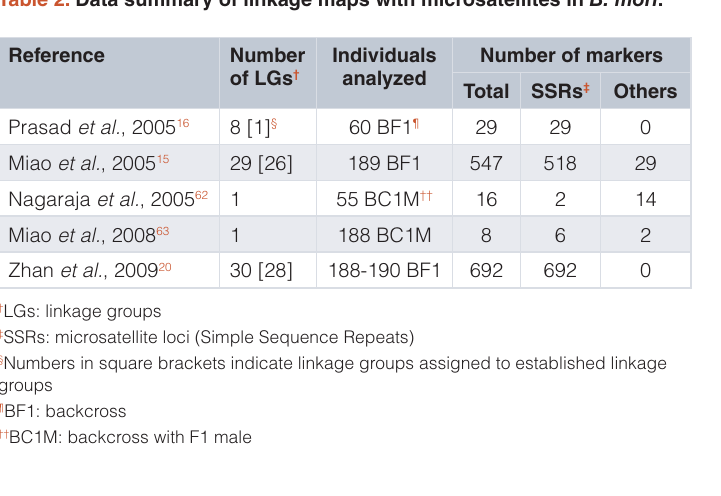
Table 2. Data summary of linkage maps with microsatellites in B. mori